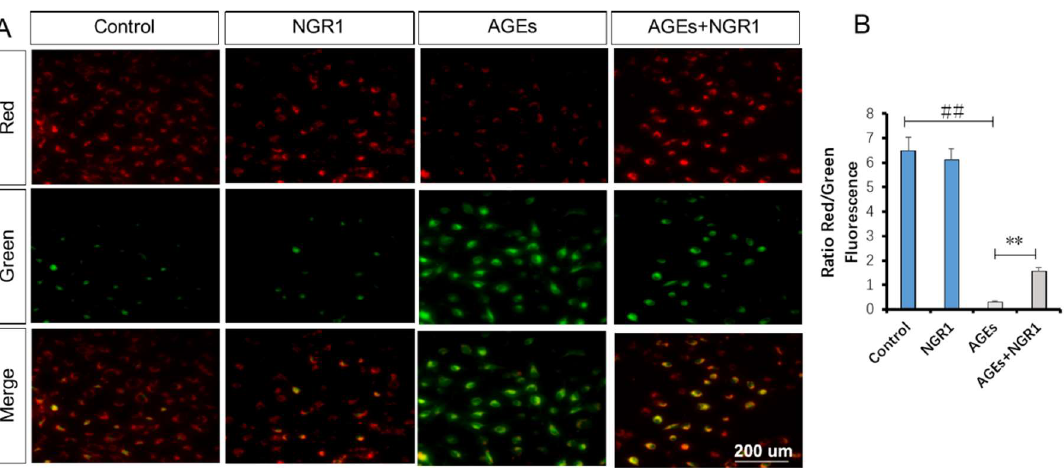
Figure 7. NGR1 inhibited intracellular reactive oxygen species (ROS) production in HK-2 cells exposed to AGEs via upregulation of Nrf2-mediated HO-1 expression. ( A ) Fluorescence images and ( B ) the bar diagram show ROS levels in HK-2 cells; the fluorescence intensity of ROS was measured using a fluorescence microplate reader, where the bar represents 200 μm; ( C ) representative images of nuclear Nrf2 and HO-1 protein expression determined by Western blot; ( D – E ) relative protein expressions of nuclear Nrf2 to Lamin B1, and HO-1 to β-actin are expressed in the bar graphs. All data are presented as the mean ± SD ( n = 3). ## p < 0.01 vs. the control group; * p < 0.05 or ** p < 0.01 vs. the AGE group.